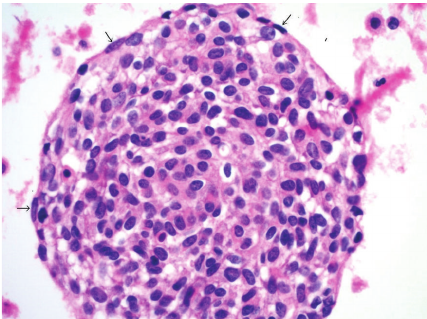
Figure 5: A higher magnification view of DSRCT involving fluid. Theimageshowsacohesiveandcrowdedgroupoflesionalcellsfrom the pleural fluid with central epithelioid forms. Small arrows mark peripheral elongated/spindled forms. Some of these cells have more dense chromatin, while others have chromatin that is similar to that seen in the epithelioid cells within the body of the island (cell block, hematoxylin and eosin stain,